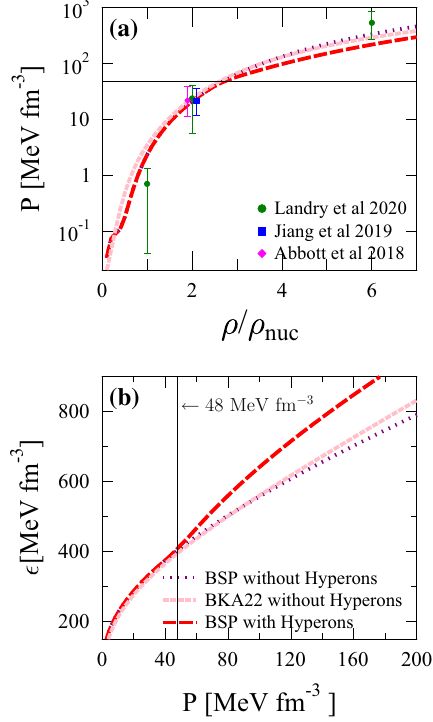
Fig. 3 EOS of NSs with and without hyperons. a Pressure as a func- tion of the ratio of density to saturation density and b energy density as a function of pressure. For comparison, some NS pressures con- straintsaregiven.First,fromGW170817[15],second,fromrecentnon- parametric analysis [9] while the third is the constraint from the joint of PSR J0030+0451, GW170817, and the nuclear data analysis [30]. The horizontal line in a and the vertical line in b are a marker P ≈ 48 MeVfm − 3 when the hyperons start to